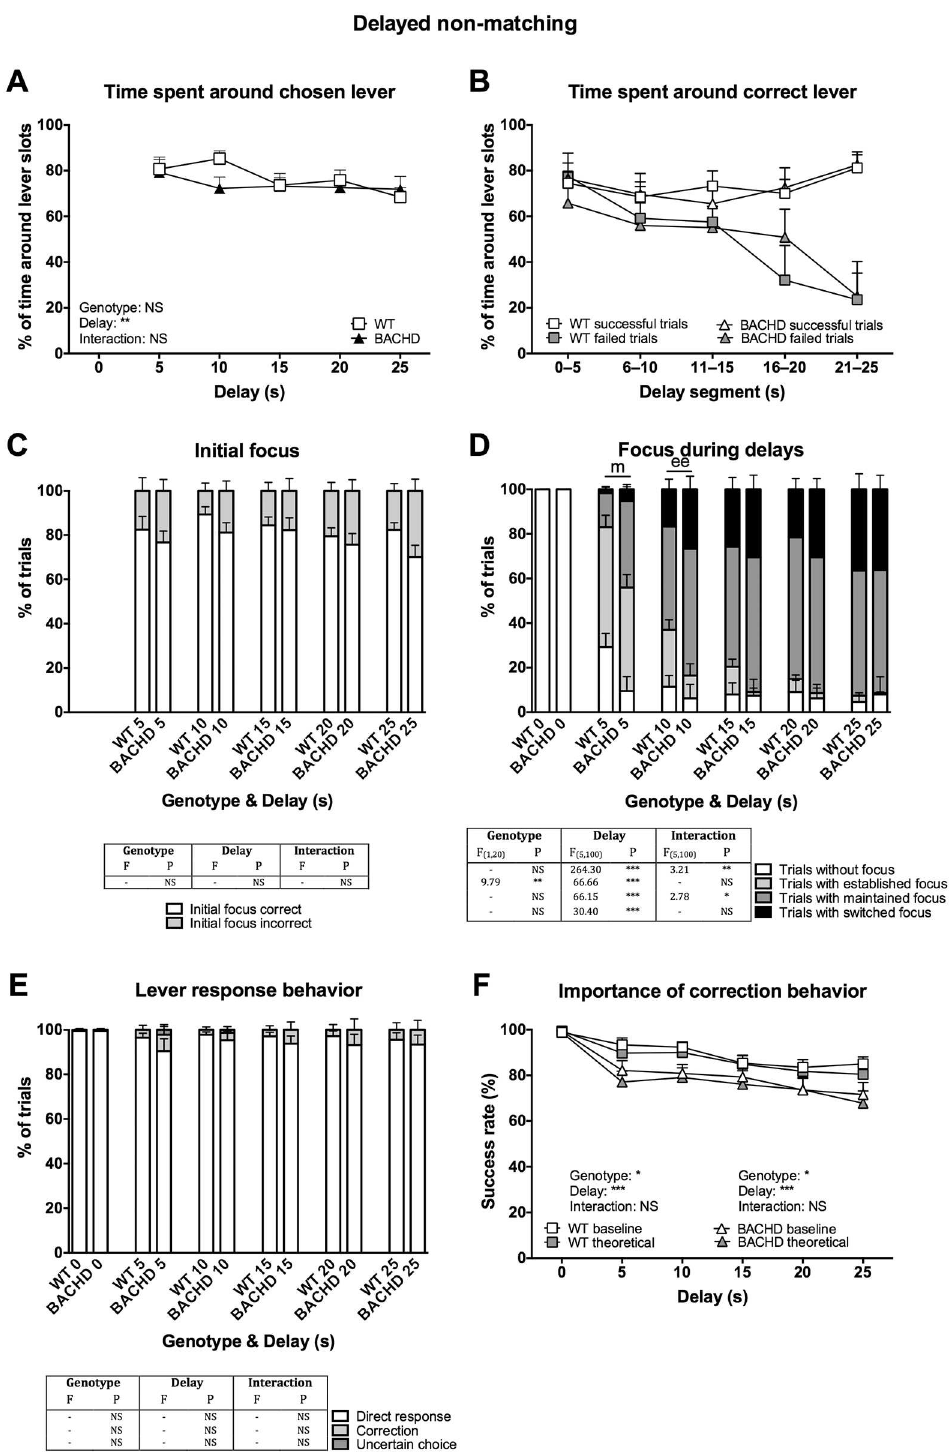
Fig 11. Video-scored behavior in relation to performance on delayed non-matching to position. The graphs show variousaspects of the behaviors scored from video recordings in relationto the rats’ performance in the delayednon-matching to positiontest. Graphs indicate group mean plus standarderror. (B) concernsthe 25-seconddelay step. In (F), the data that is labeled"theoretical"displaysthe theoretical success rates, as if the rats had responded accordingto their initial lever interest and not performed a correction behavior.